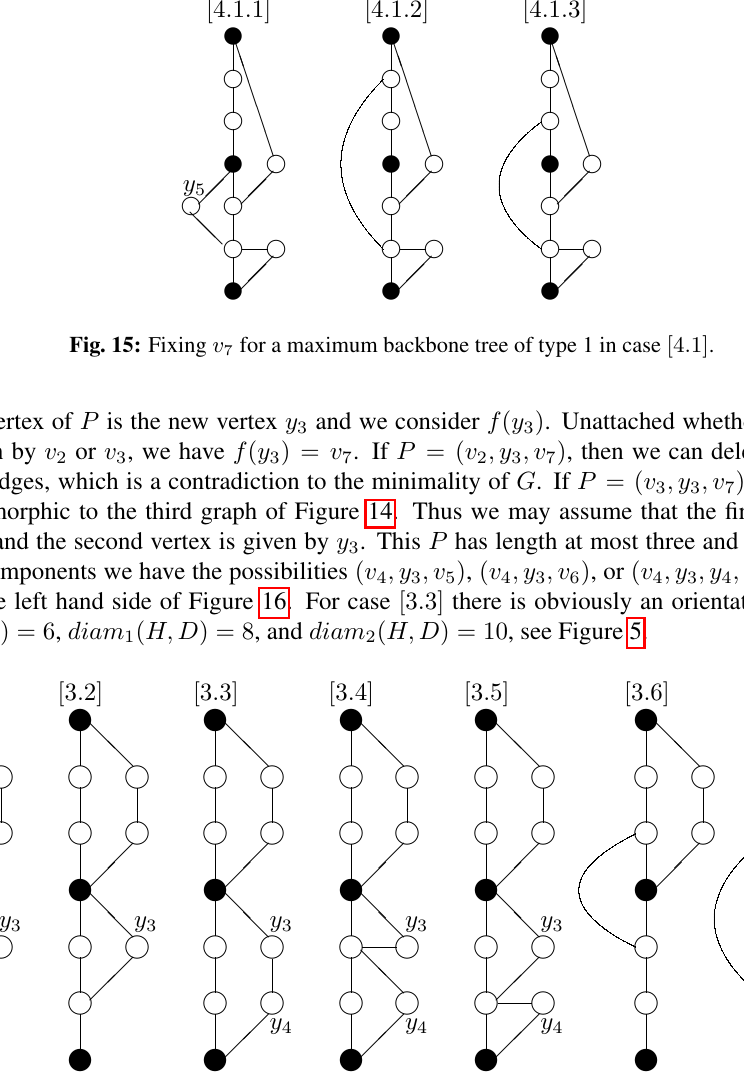
Fig. 16: Fixing v 7 for a maximum backbone tree of type 1 in case [3]